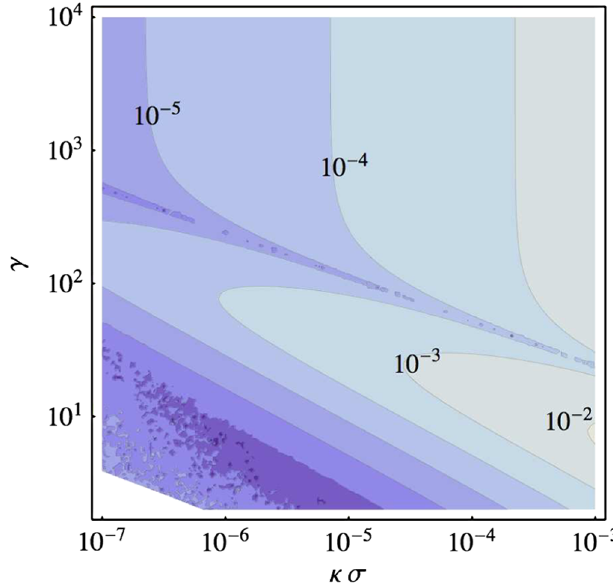
FIG. 18. (Color) The relative difference jð b (cid:1) a Þj =b for a the average energy lost using Eq. (32), and b being the result in Eq. (81).